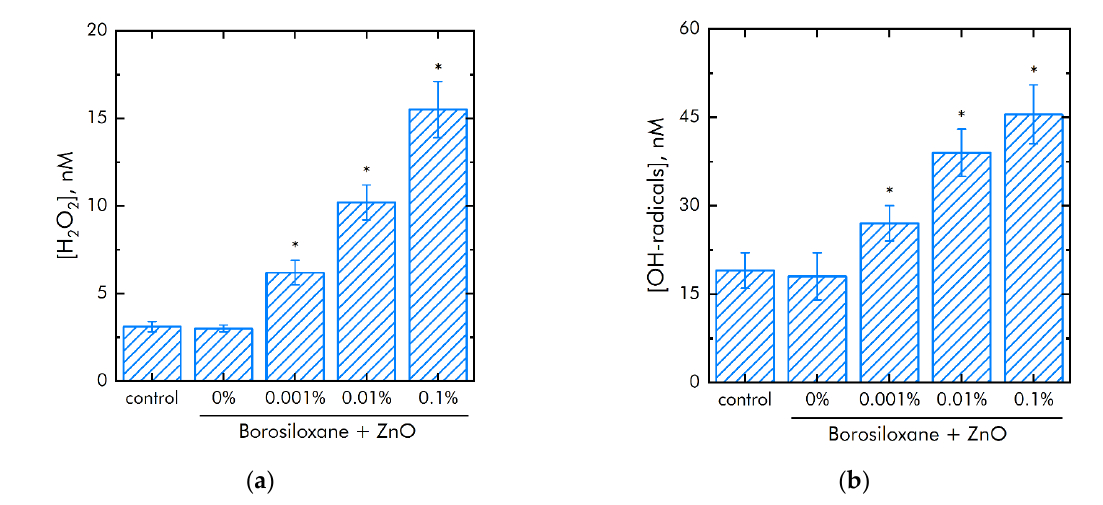
Figure 5. Effect of composite material containing borosiloxane and ZnO nanoparticles on the generation of reactive oxygen species: ( a ) Formation of hydrogen peroxide (2 h, 40 °C); ( b ) Generation of hydroxyl radicals (2 h, 80 °C); * indicate a significant difference at 5% level in comparison with the control (p < 0.05). Data are presented as mean values and standard errors.